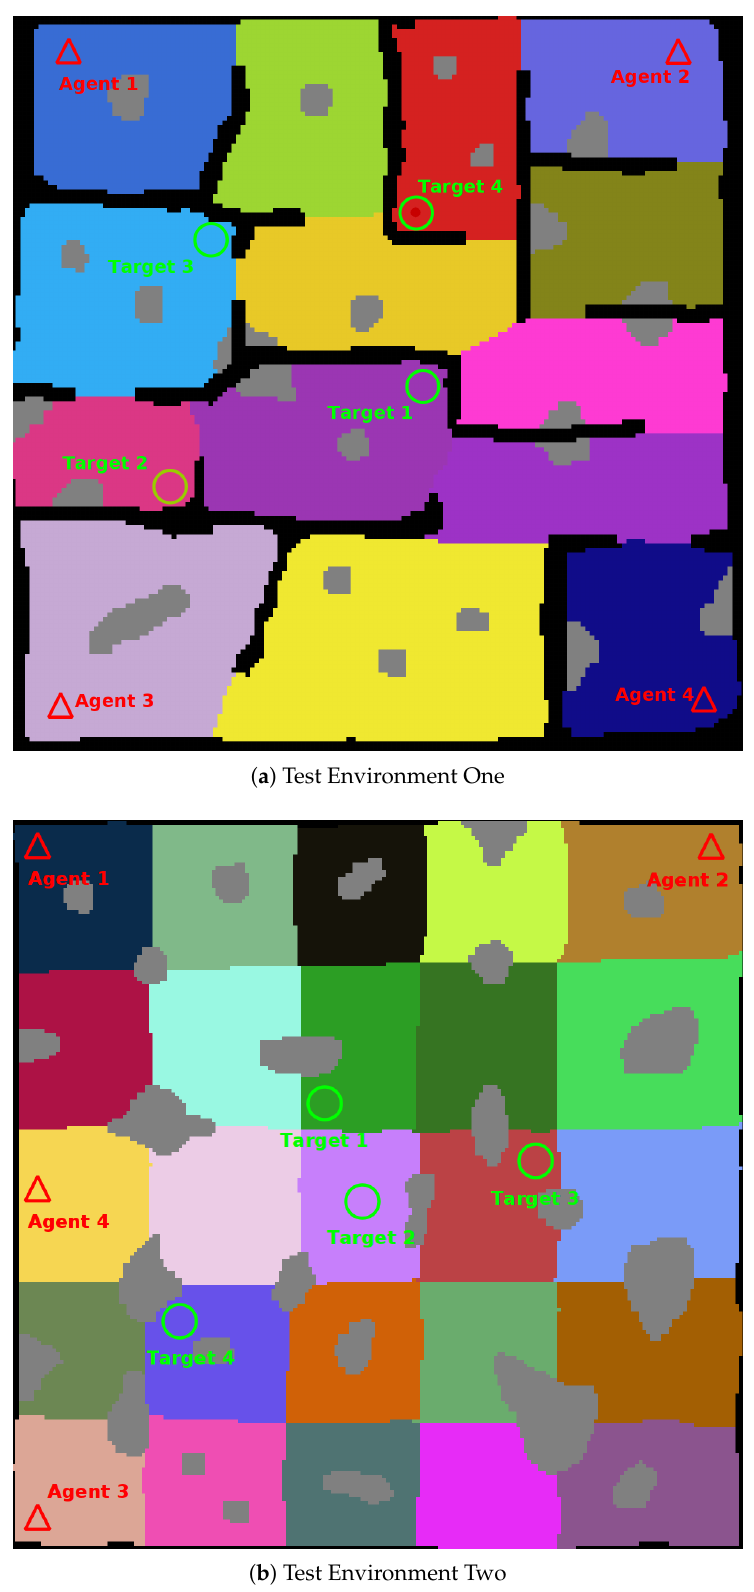
Figure 11. Complete Test Environments. Black Cells : Known Obstacle Cells, White Cells : Explored Empty Space Cells, Coloured Cells : Unexplored Empty Cells (Search Regions), Grey Cells : Unknown Obstacle Cells, Triangles : Agent Spawn Locations, Circles : Target Spawn